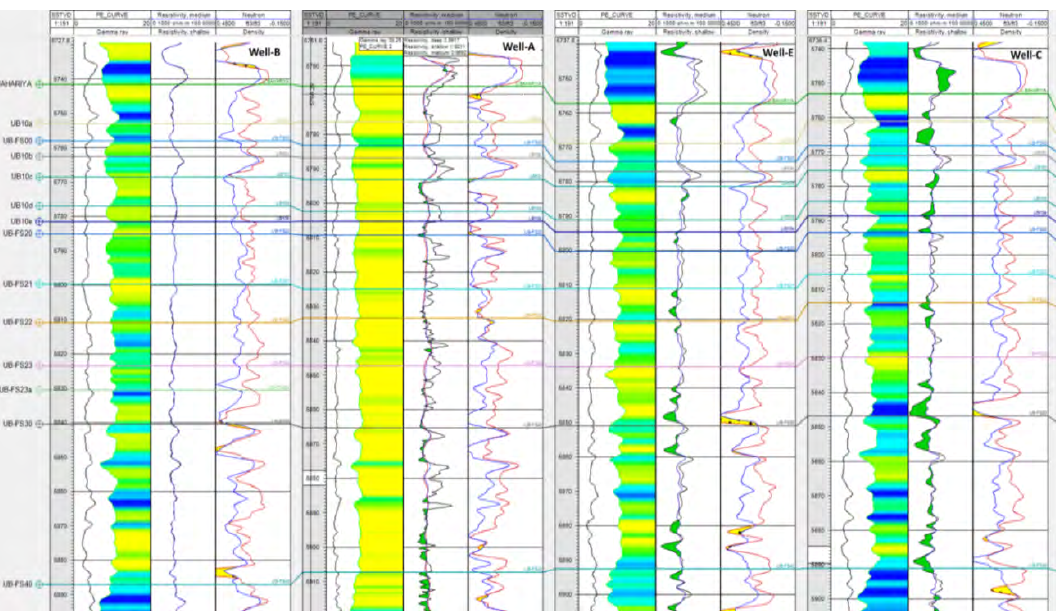
Figure 3. Upper Bahariya reservoir correlation